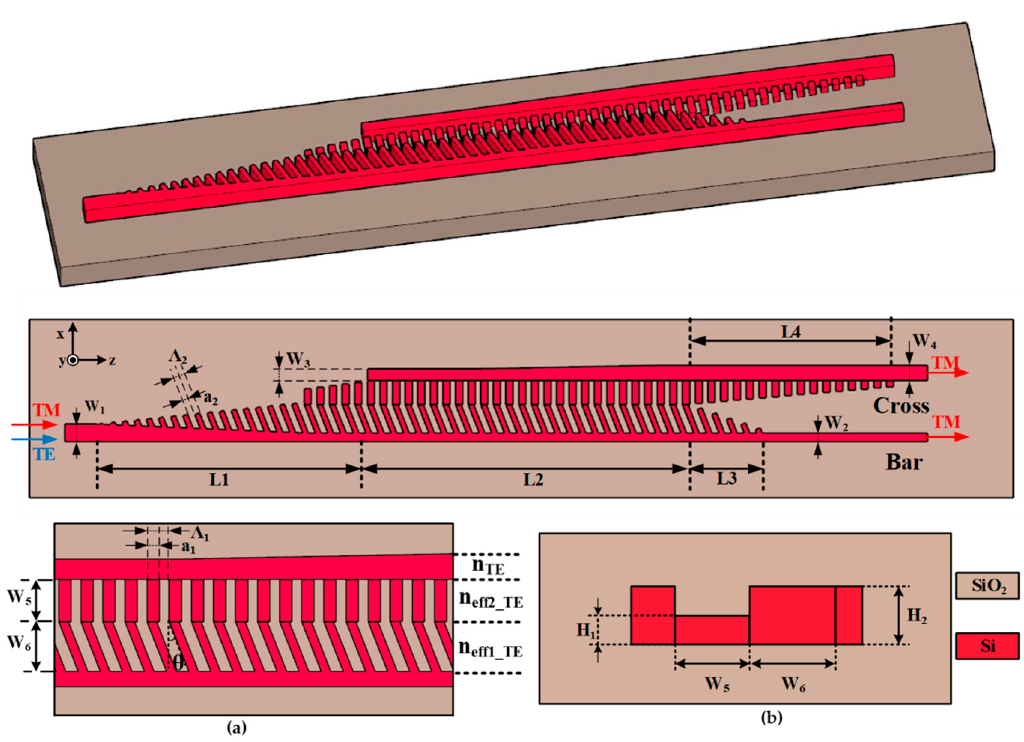
Figure 1. The structure of the device: ( a ) partially enlarged view and ( b ) cross-sectional